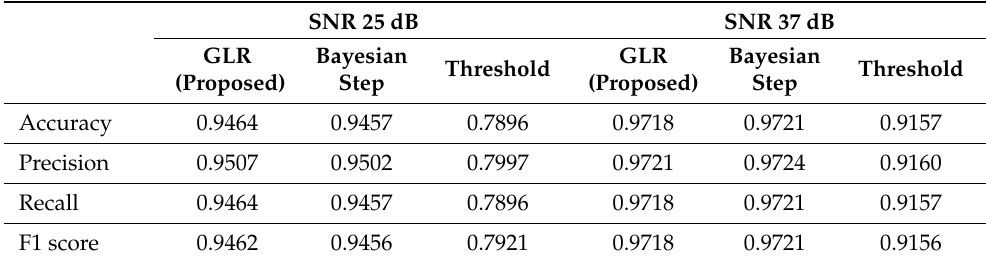
Figure 16. Histogram of classification accuracy at 37 dB SNR. Table 4. Classification metrics for three different methods at 25 dB and 37 dB